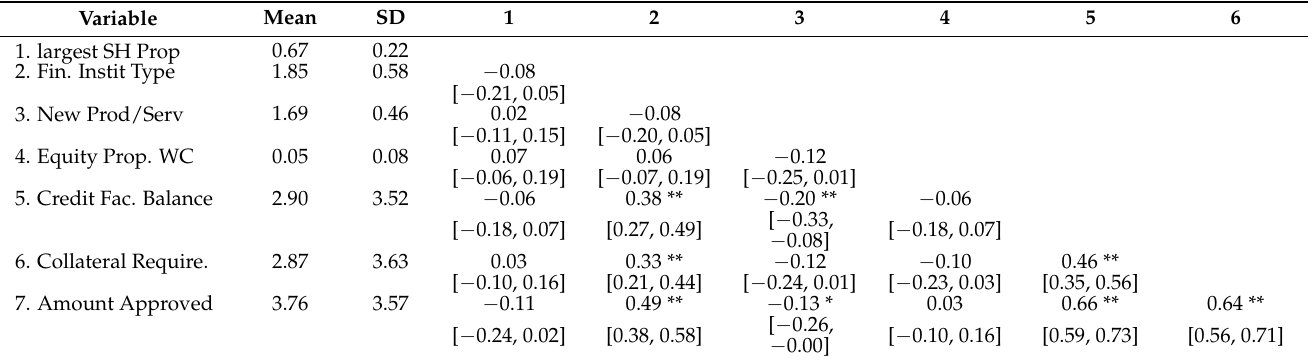
Table 1. Descriptive Statistics and the Correlation Matrix.